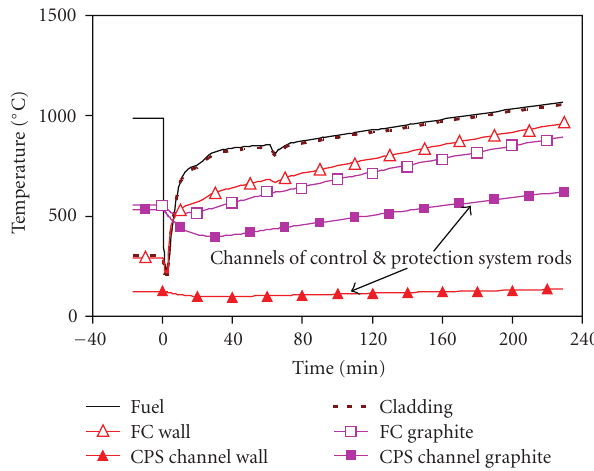
Figure 15: MCP pressure header break with failure of ECCS. The heat transfer from FC channels to CPS cooling channels is taken into account. Behaviour of maximum temperatures of fuel, cladding, FC wall, graphite columns and CPS channel wall.